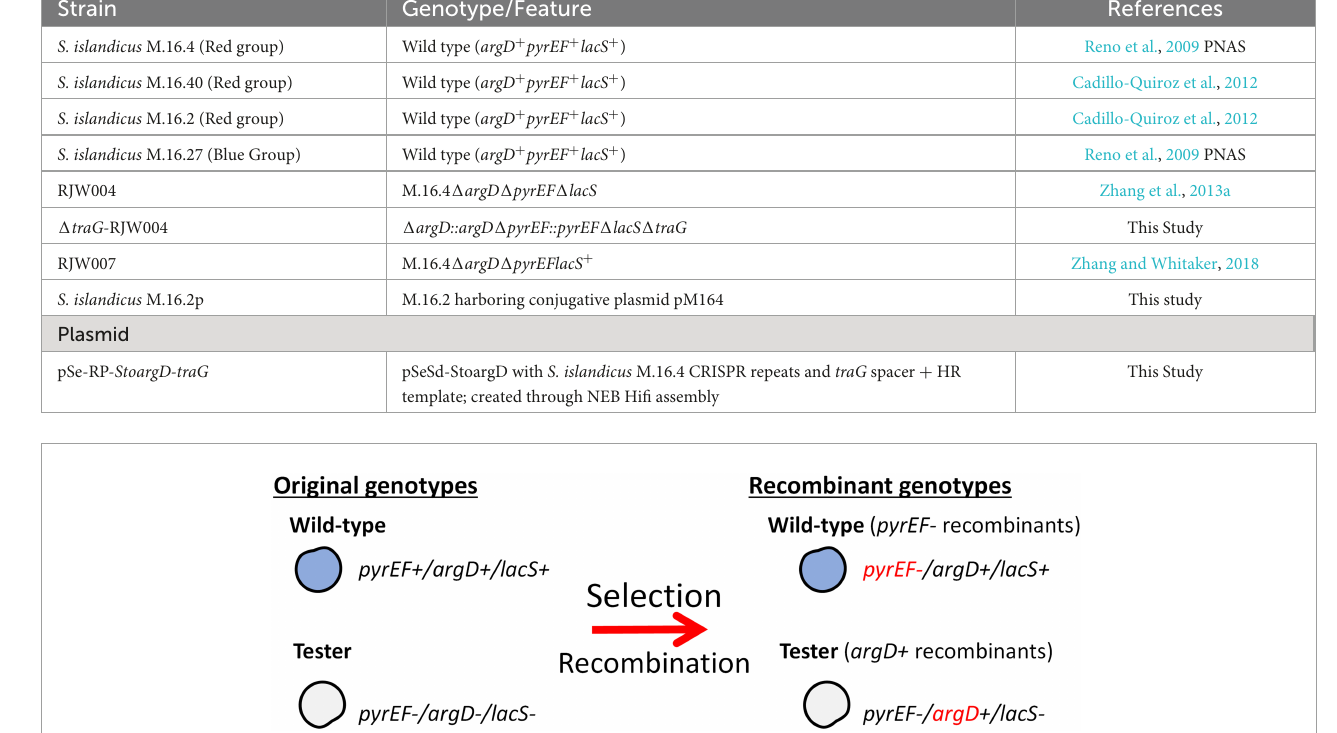
TABLE 1 Strains and plasmids used in this study.